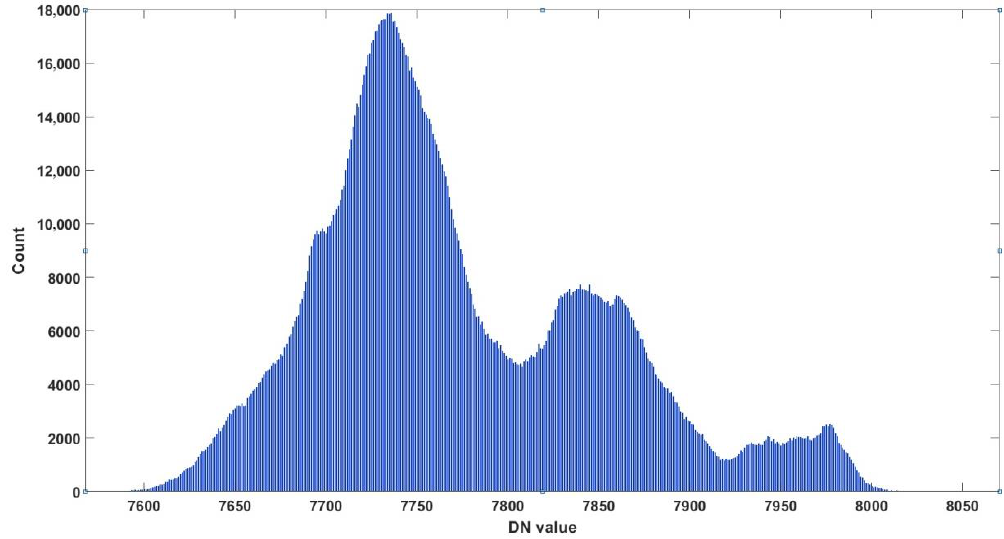
Figure 8. DN (digital number) value distribution statistics.